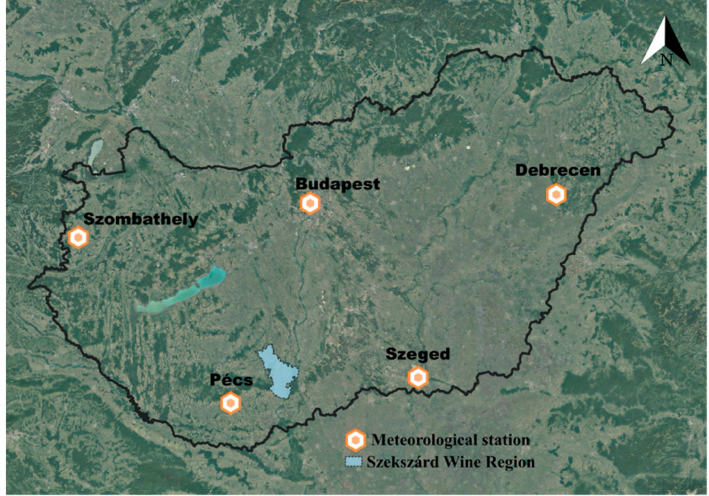
Figure 2. Location of the meteorological